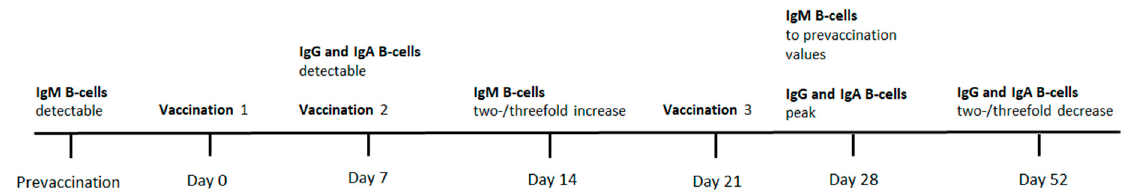
Figure 2. Timeline regarding the kinetics in Ueki et al. (1990).